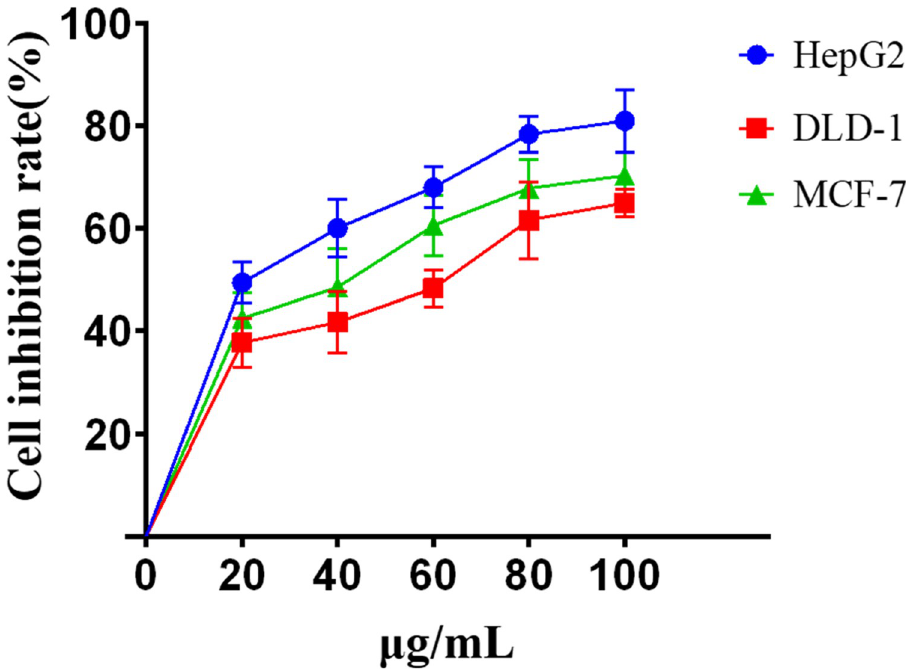
Fig 1. Inhibition rates of lingonberry extract on proliferation of various cancer